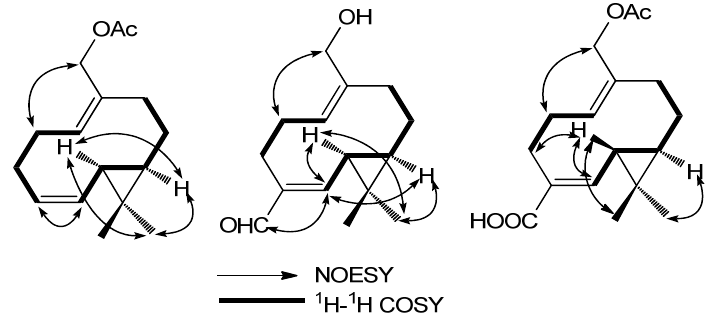
Figure 3. The correlations of structures, 1 H- 1 H COSY and Key HMBC of 3 .